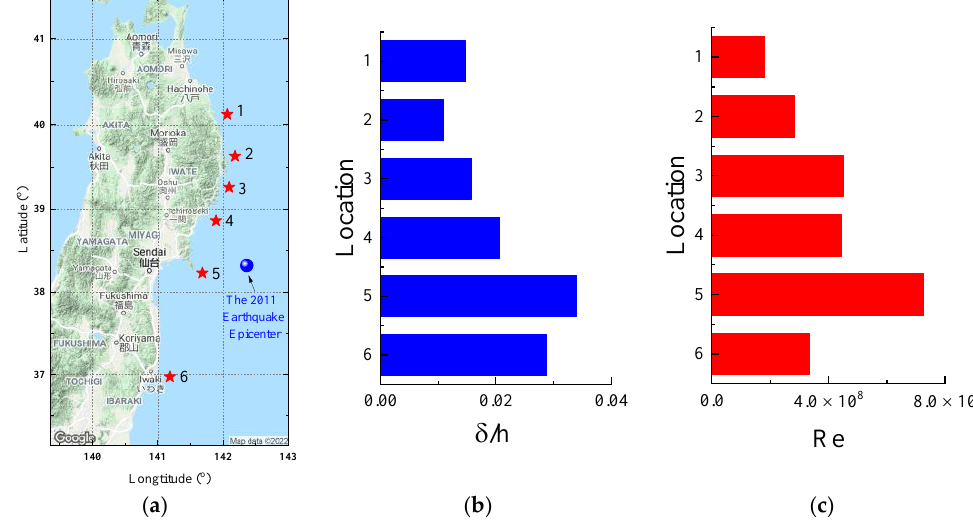
Figure 1. ( a ) Location of the GPS station, ( b ) boundary layer thickness, ( c ) Reynolds number. Table 1. GPS wave gauge data used in this study.